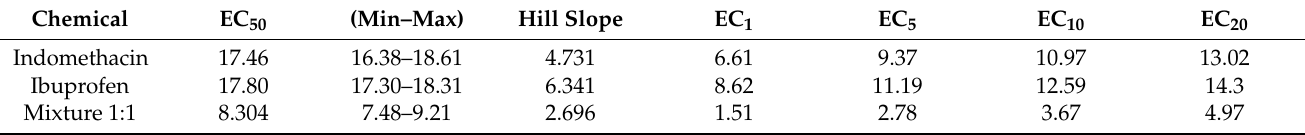
Table 1. EC values (in mg/L) from toxicity